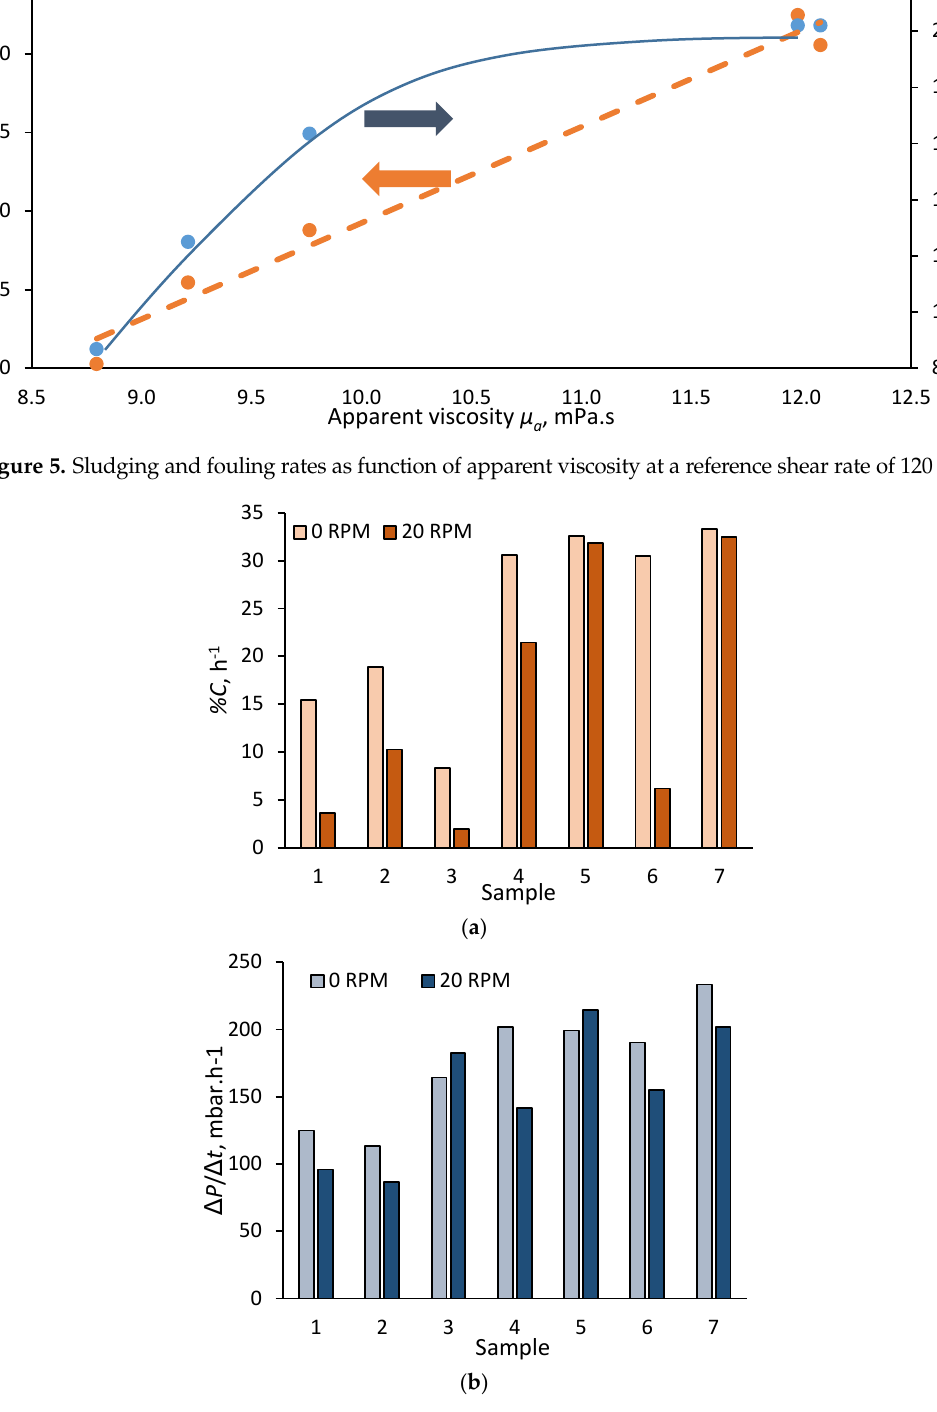
Figure 6. Rate of ( a ) percentage of membrane clogged and ( b ) pressure increase across seven samples, MLSS ~11 g·L −1 , for stationary and reciprocating membrane (at 20 RPM).